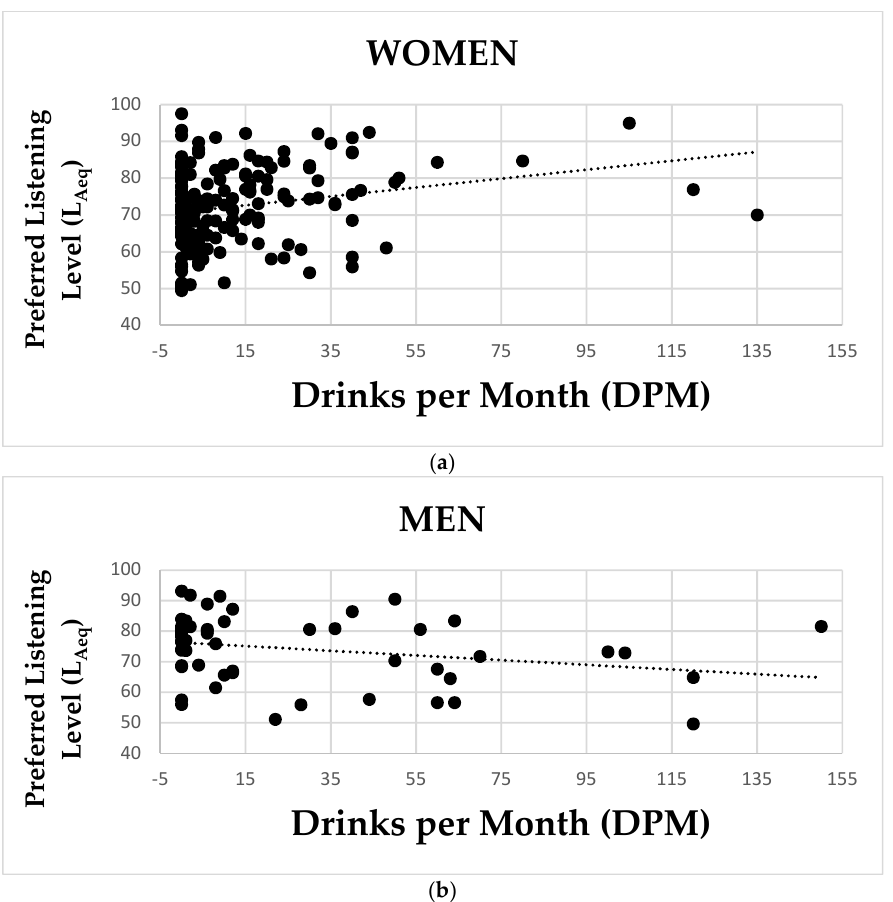
Figure 5. ( a ) The scatterplot for drinks per month (DPM) and preferred listening level (L Aeq ) is shown for women only ( n = 161). The linear regression line is also shown; ( b ) The scatterplot for drinks per month (DPM) and preferred listening level (L Aeq ) is shown for men only ( n = 55). The linear regression line is also shown.